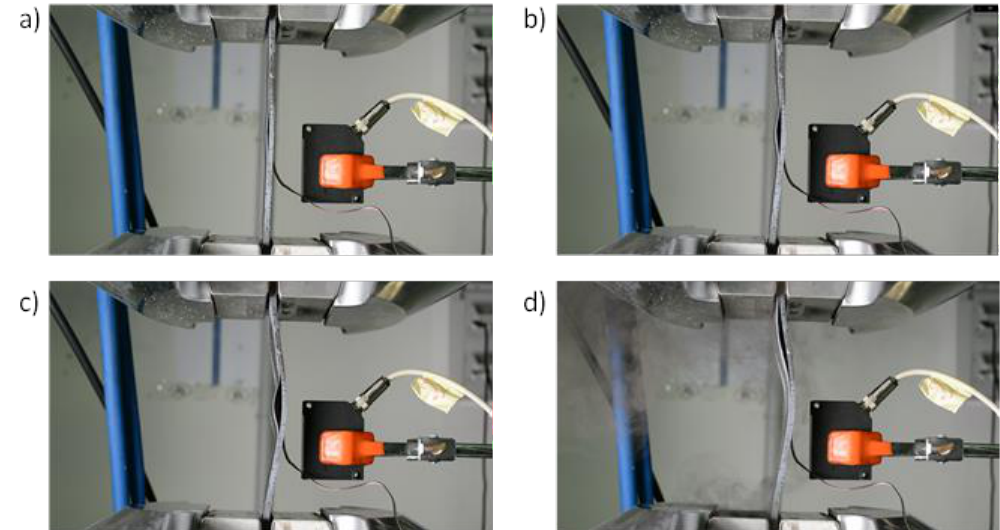
Figure 13. Toughened specimen deformed shape at ( a ) delamination onset, ( b , c ) intermediate delamination state and ( d ) complete delamination.